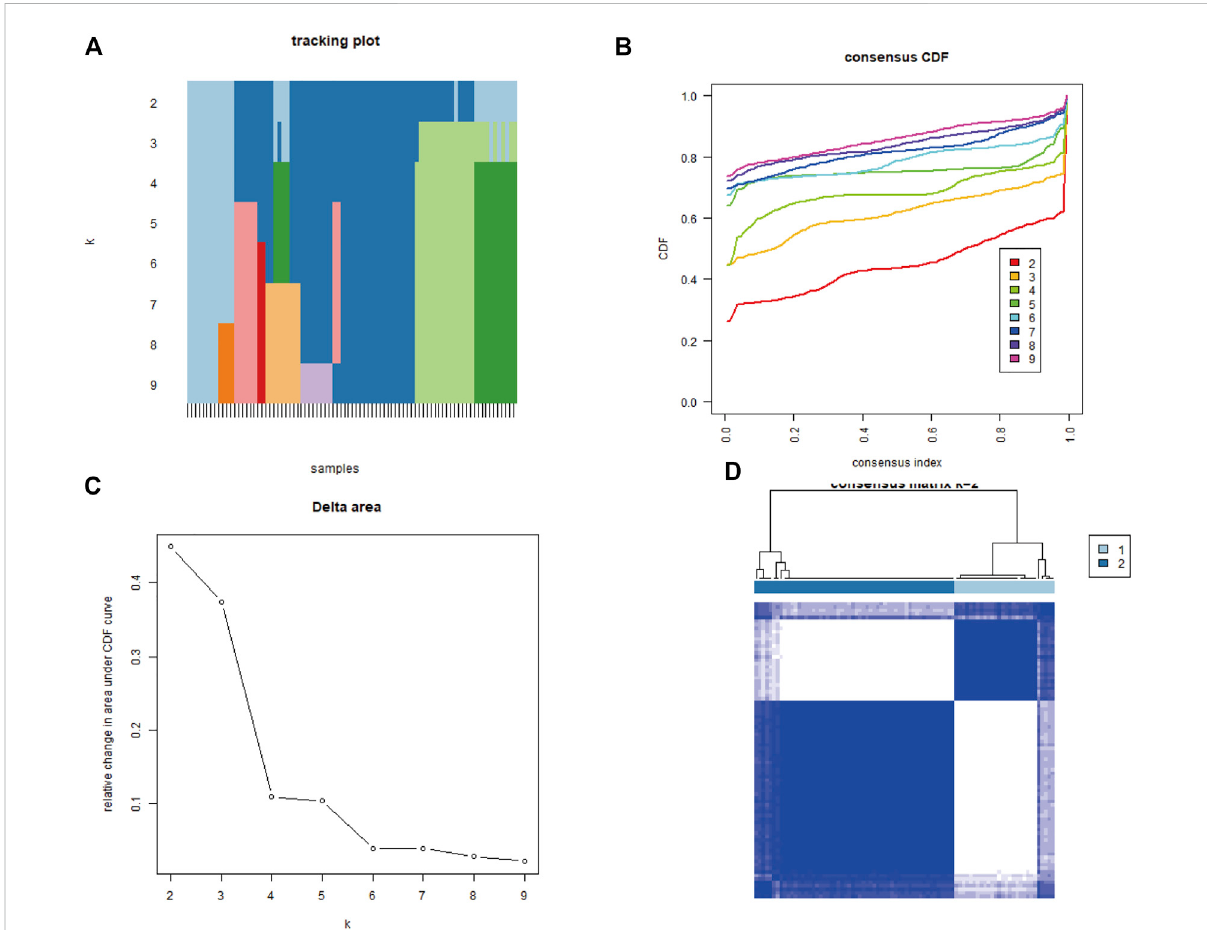
FIGURE 5 Identi fi cation of two mitochondrial dysfunction-related clusters using consensus clustering analysis of mitochondrial